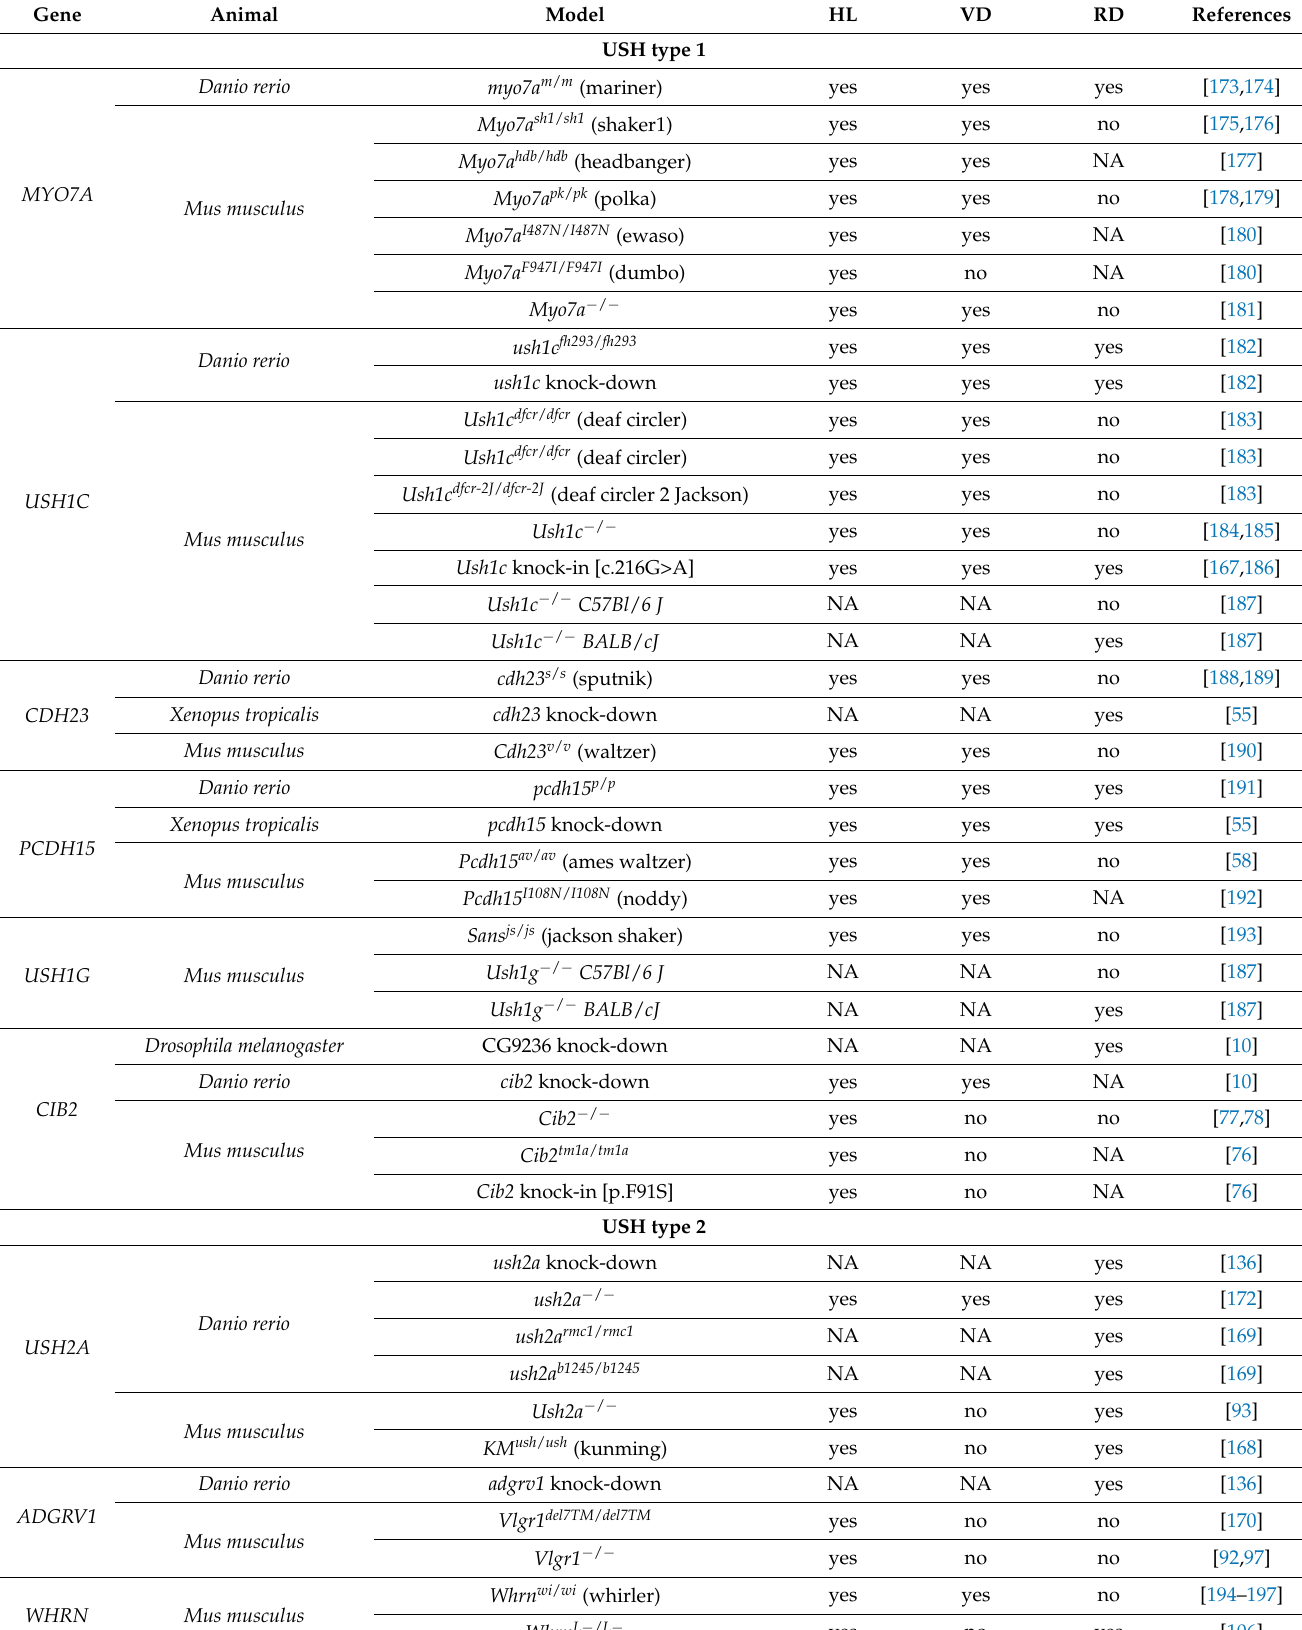
Table 2. Described animal models of Usher